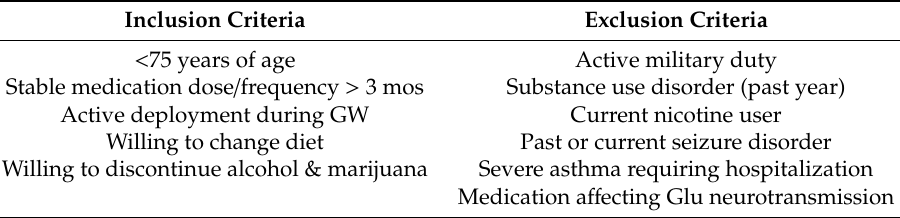
Table 1. Inclusion and exclusion criteria for clinical